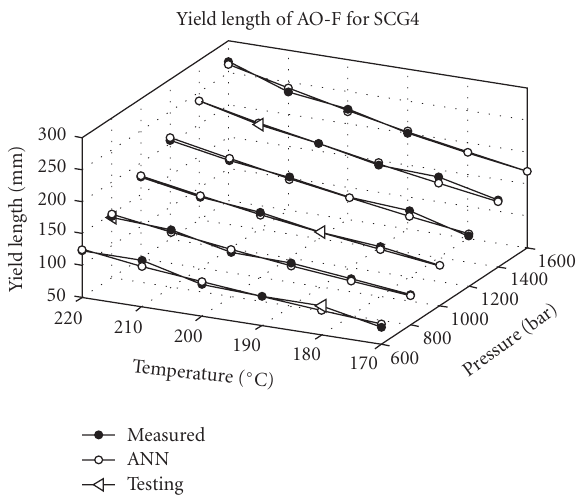
Figure 15: Comparison of the measured and predicted yield length based on temperature and pressure for A0-F.